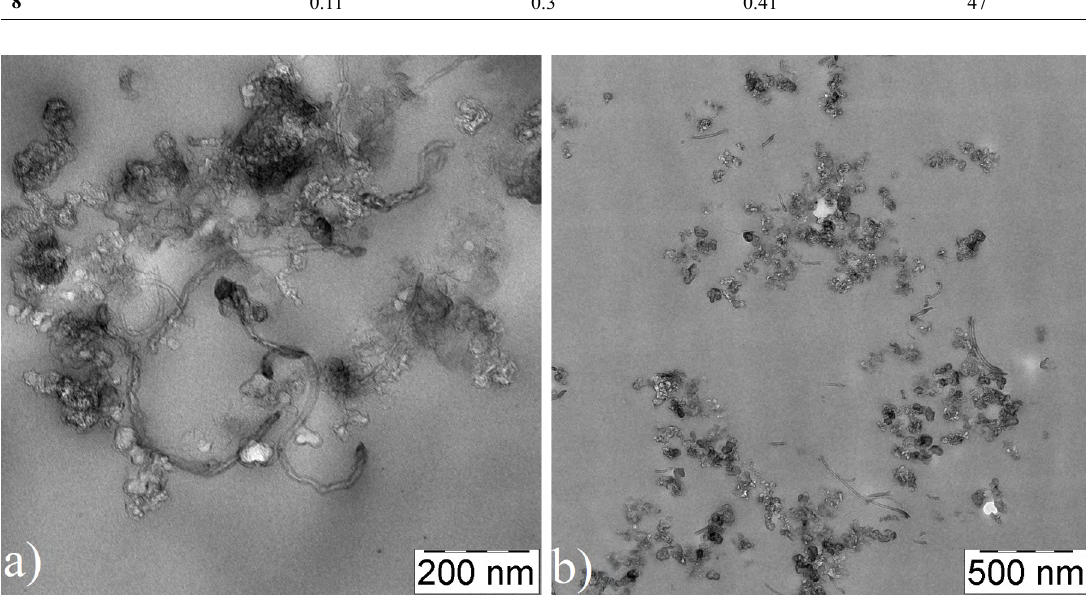
Figure 10. TEM micrographs for MCFFS (a) conductive networks; (b) larger view of scattered CB and CNT.